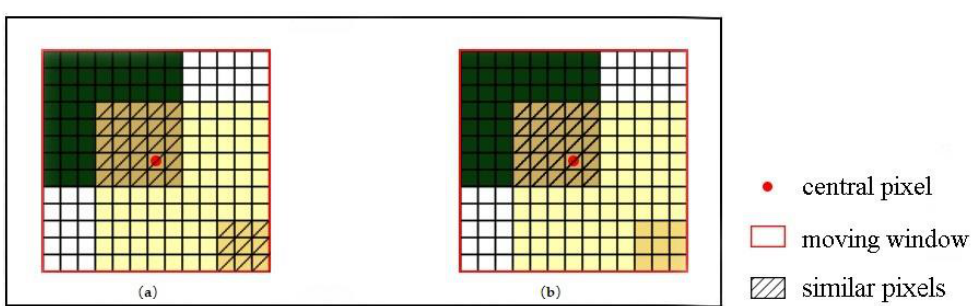
Figure 7. The selected results. ( a ) spectral threshold; ( b ) improved approach.